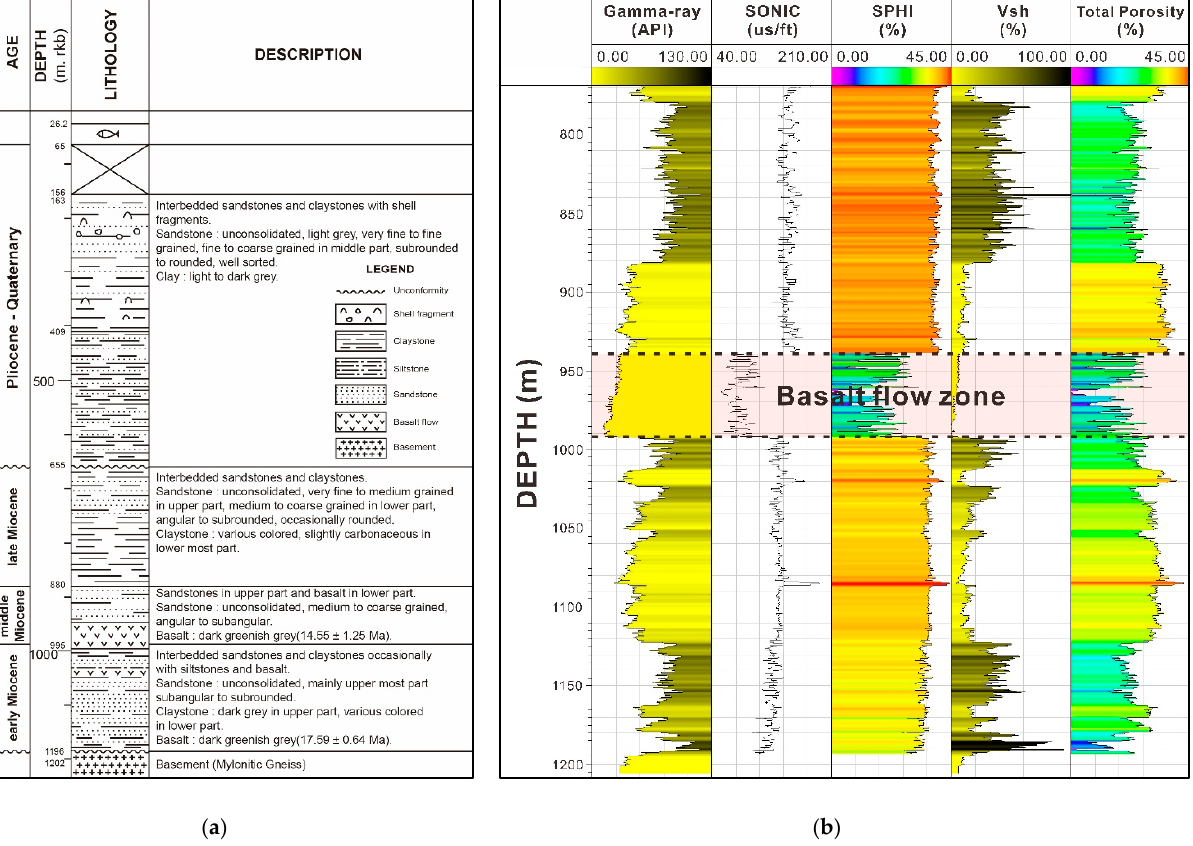
Figure 2. ( a ) Geological summary of previous well-log of an adjacent study area (modified from [23]) and ( b ) well-log analysis of ( a ) with storage potential zone. SPHI: sonic-derived porosity. Vsh: shale volume.